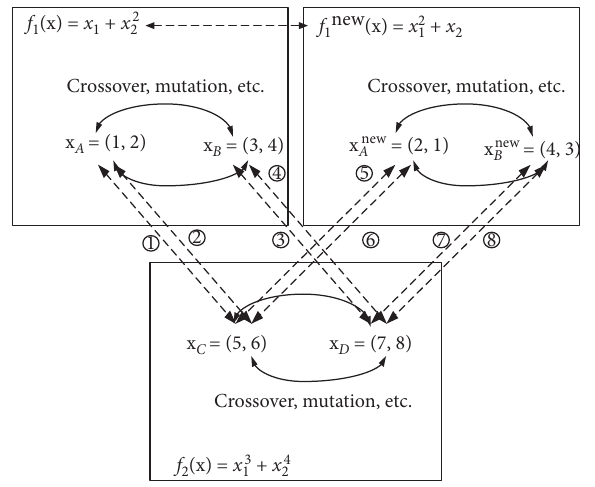
Figure 3: Corresponding relationship between two individuals before and after changing the order of variables for multitasking optimization